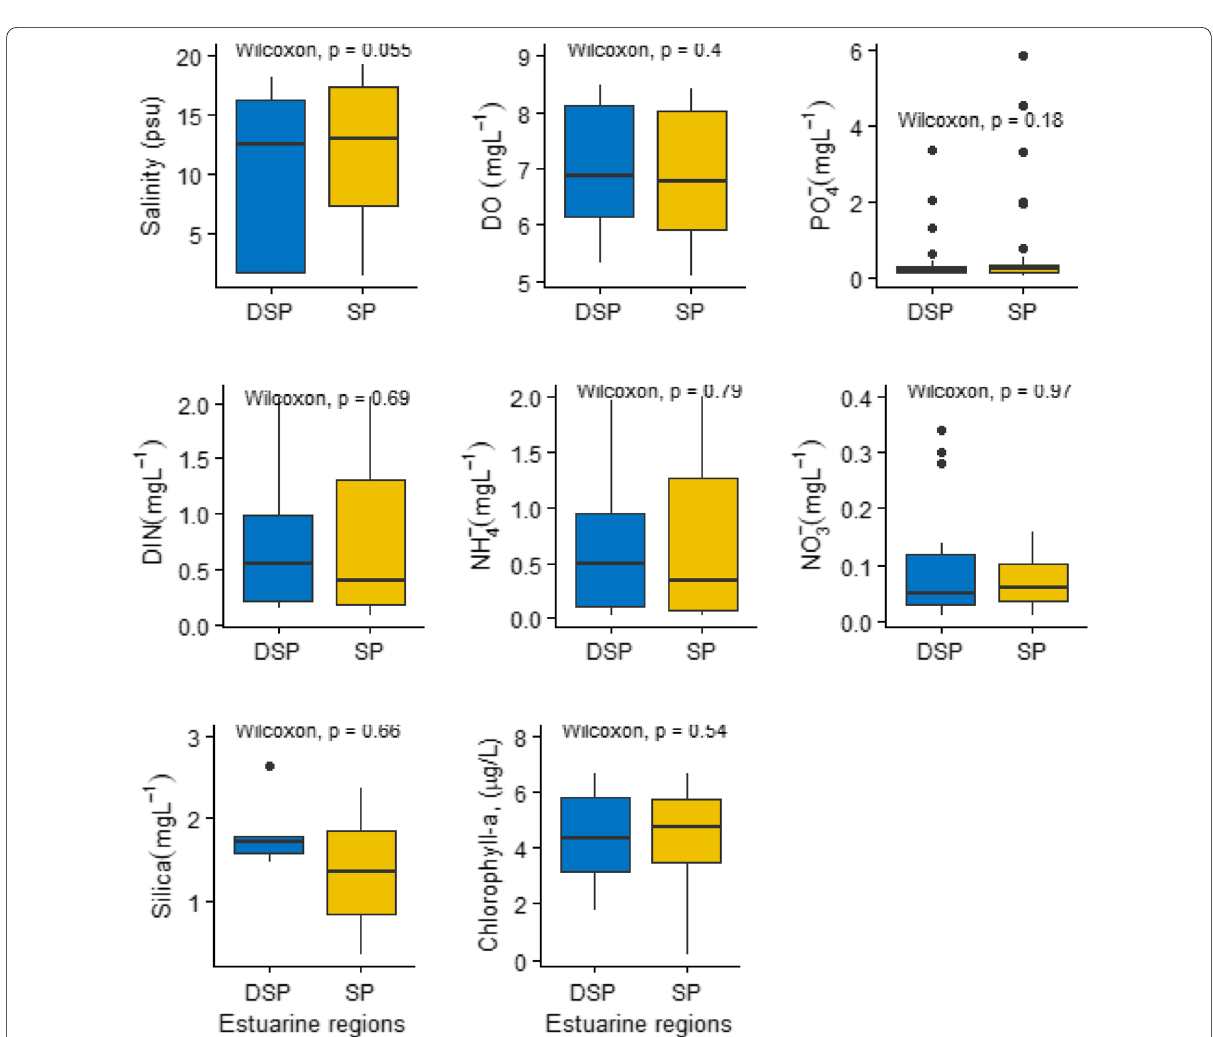
Fig. 12 Spatial distributions of major hydro‑chemical parameter, dissolved inorganic nutrients and chlorophyll‑a in the upper Pasur River estuary between salt plug area (SP) and downstream of salt plug area (DSP) as shown in Fig.